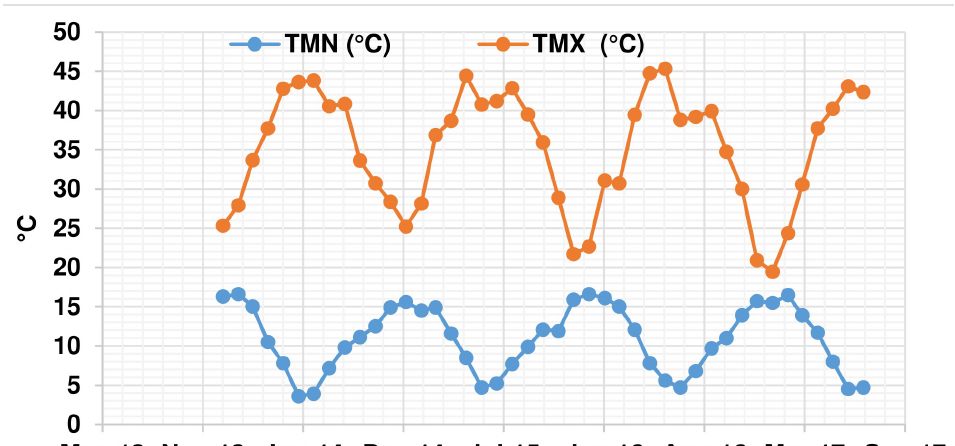
Figure 4. Historical trend of TMN and